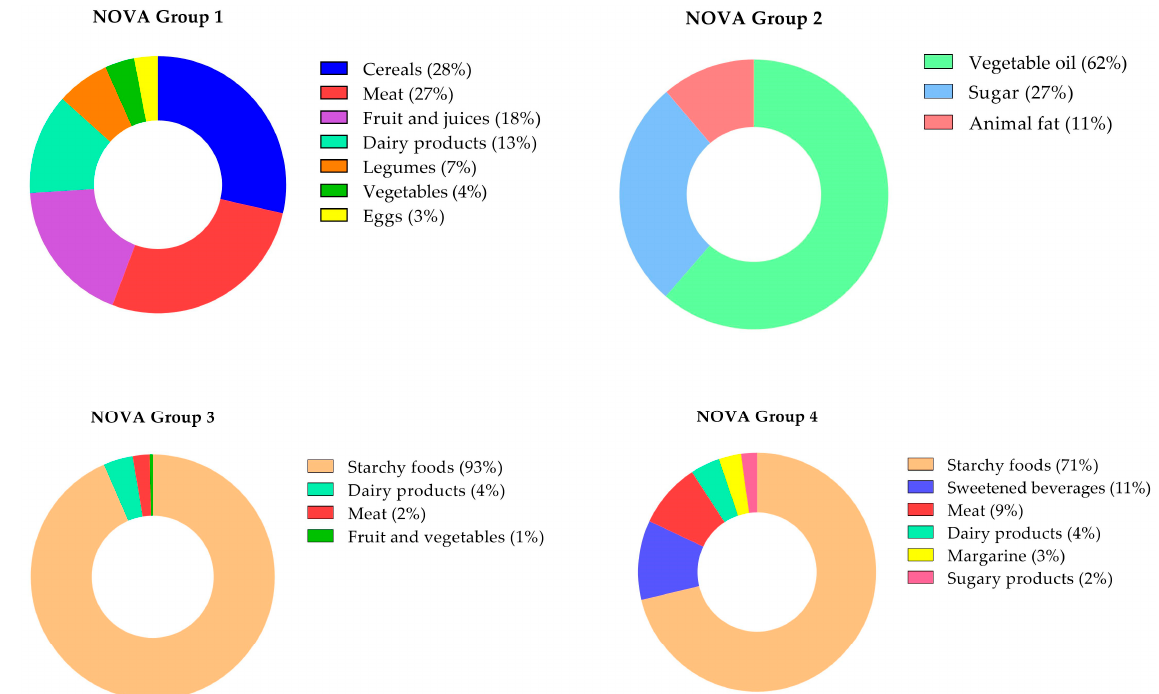
Figure 2. Relative contribution (%) of each food group to unprocessed, processed, and ultra-processed food consumption. NOVA Group 1 (unprocessed food); NOVA Group 2 (processed culinary ingredients); NOVA Group 3 (processed food); NOVA Group 4 (ultra-processed food).